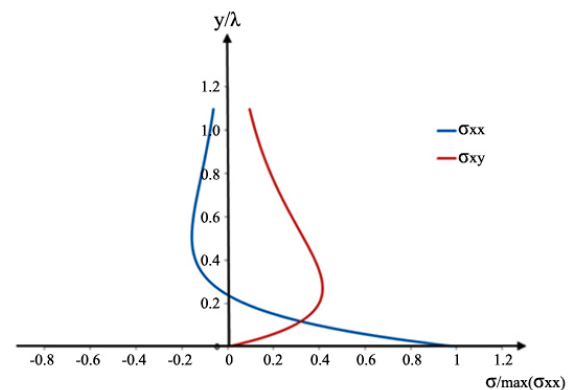
Figure 14. Stress variations associated with the incident edge wave, as a function of depth y from the edge.